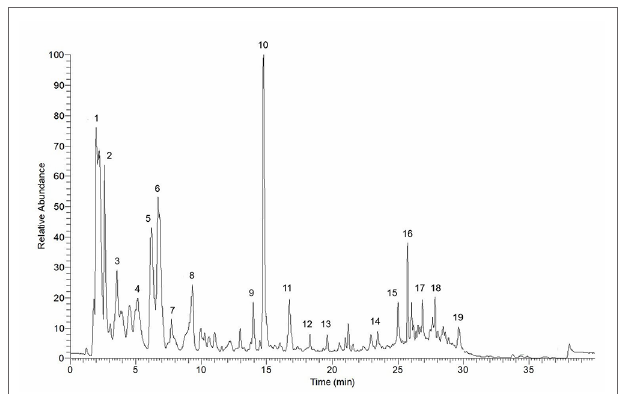
FIGURE 1 | Total ion chromatogram of aqueous extract of P. sarmentosum leaves (AEPS). Peaks are identified with numbers according to the elution order (refer to Table 1 ).